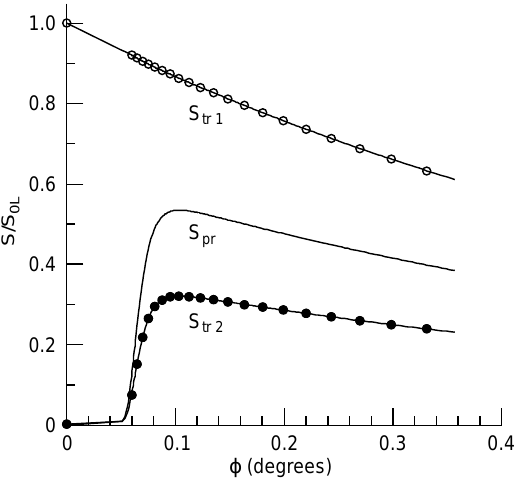
Putting L (cid:136) 4 : 5, B